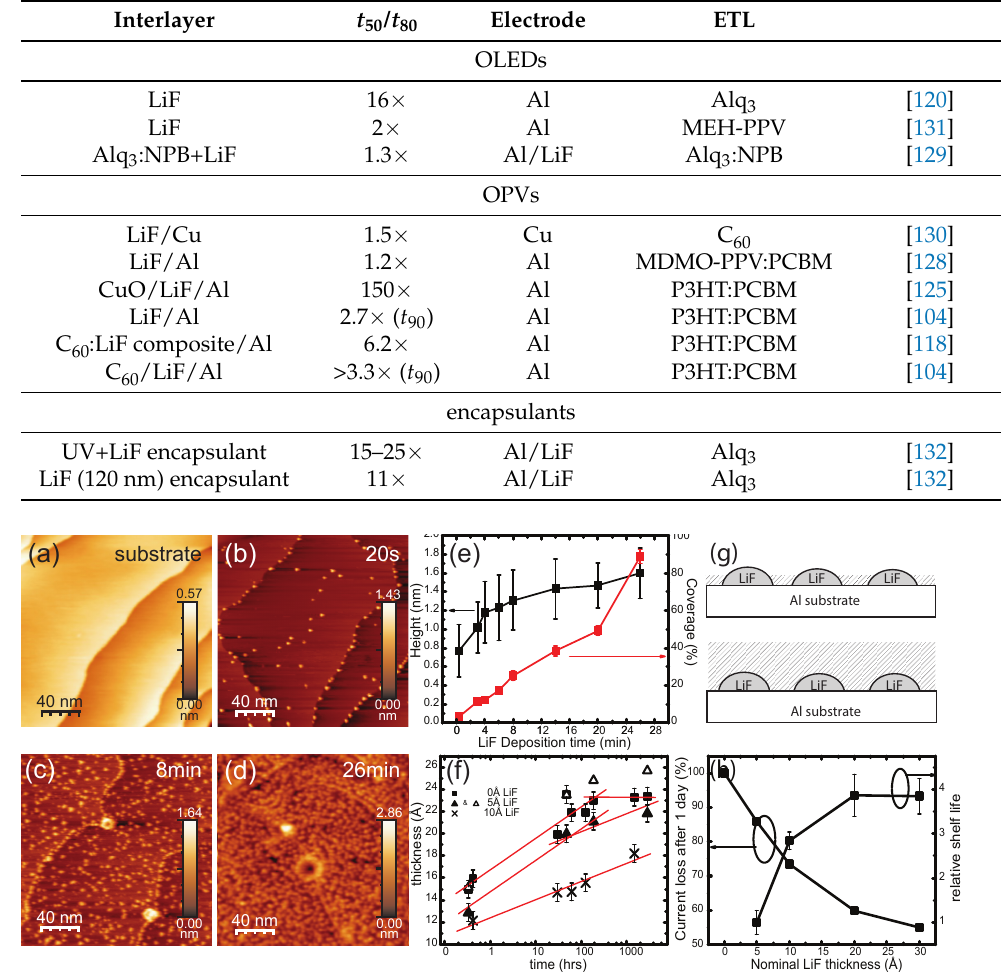
Figure 5. AFM micrographs of evaporated LiF films ( a ) bare Al ( 100 ) single crystal ( b ) after 20 s deposition of LiF ( c ) after 8 min ( d ) after 26 min ( e ) surface coverage and height as a function of LiF deposition time. Reproduced with permission from Springer Nature from Ref. [61] Copyright (2021). ( f ) Growth of oxide on Al surfaces, monitored by XPS, for thickness as estimated by the simple overlayer model. Lines represent a linear sum of reduced squares best fit of the data for the bare Al surface and the surface with 10 Å LiF deposition. Uncoated Al and 5 Å LiF coated Al both show a bend in the curve at around 60 h. The open triangles represent the predicted oxide values scaled by the LiF coverage as predicted by angle resolved XPS. Reproduced with permission from Ref. [8]. Copyright 2007, The Electrochemical Society. ( g ) Schematic oxide growth model on LiF coated Al surfaces. (Top) Initially, growth occurs between LiF islands, producing a columnar structure. As growth progresses, Al diffuses through the LiF islands and growth occurs over the islands, leading to (bottom) an embedded structure. ( h ) The loss of performance after one day, and the shelf life ( t 10 ) relative to the 0.5 nm LiF interlayer, as a function of LiF thickness for C 60 based OLED devices with Al/xLiF cathodes. The lines are a guide to the eye. Reproduced from Ref. [34] with permission of The Royal Society of